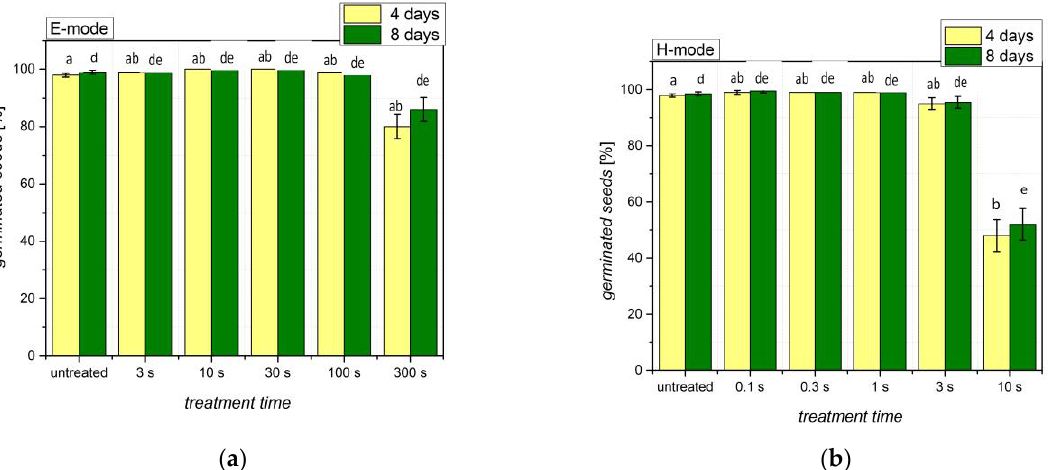
Figure 9. Germination percentage of untreated and plasma-treated wheat seeds after 4 and 8 days of incubation at germination conditions. Wheat seeds are treated in the ( a ) E-mode and ( b ) H-mode. The error bars represent the standard error. Different lowercase letters above the bars represent statistically significant differences ( p < 0.05; post hoc Tukey’s range tests) between treatments for an incubation time of 4 and 8 days. Mean values (±SE) for the respective duplicates are given.